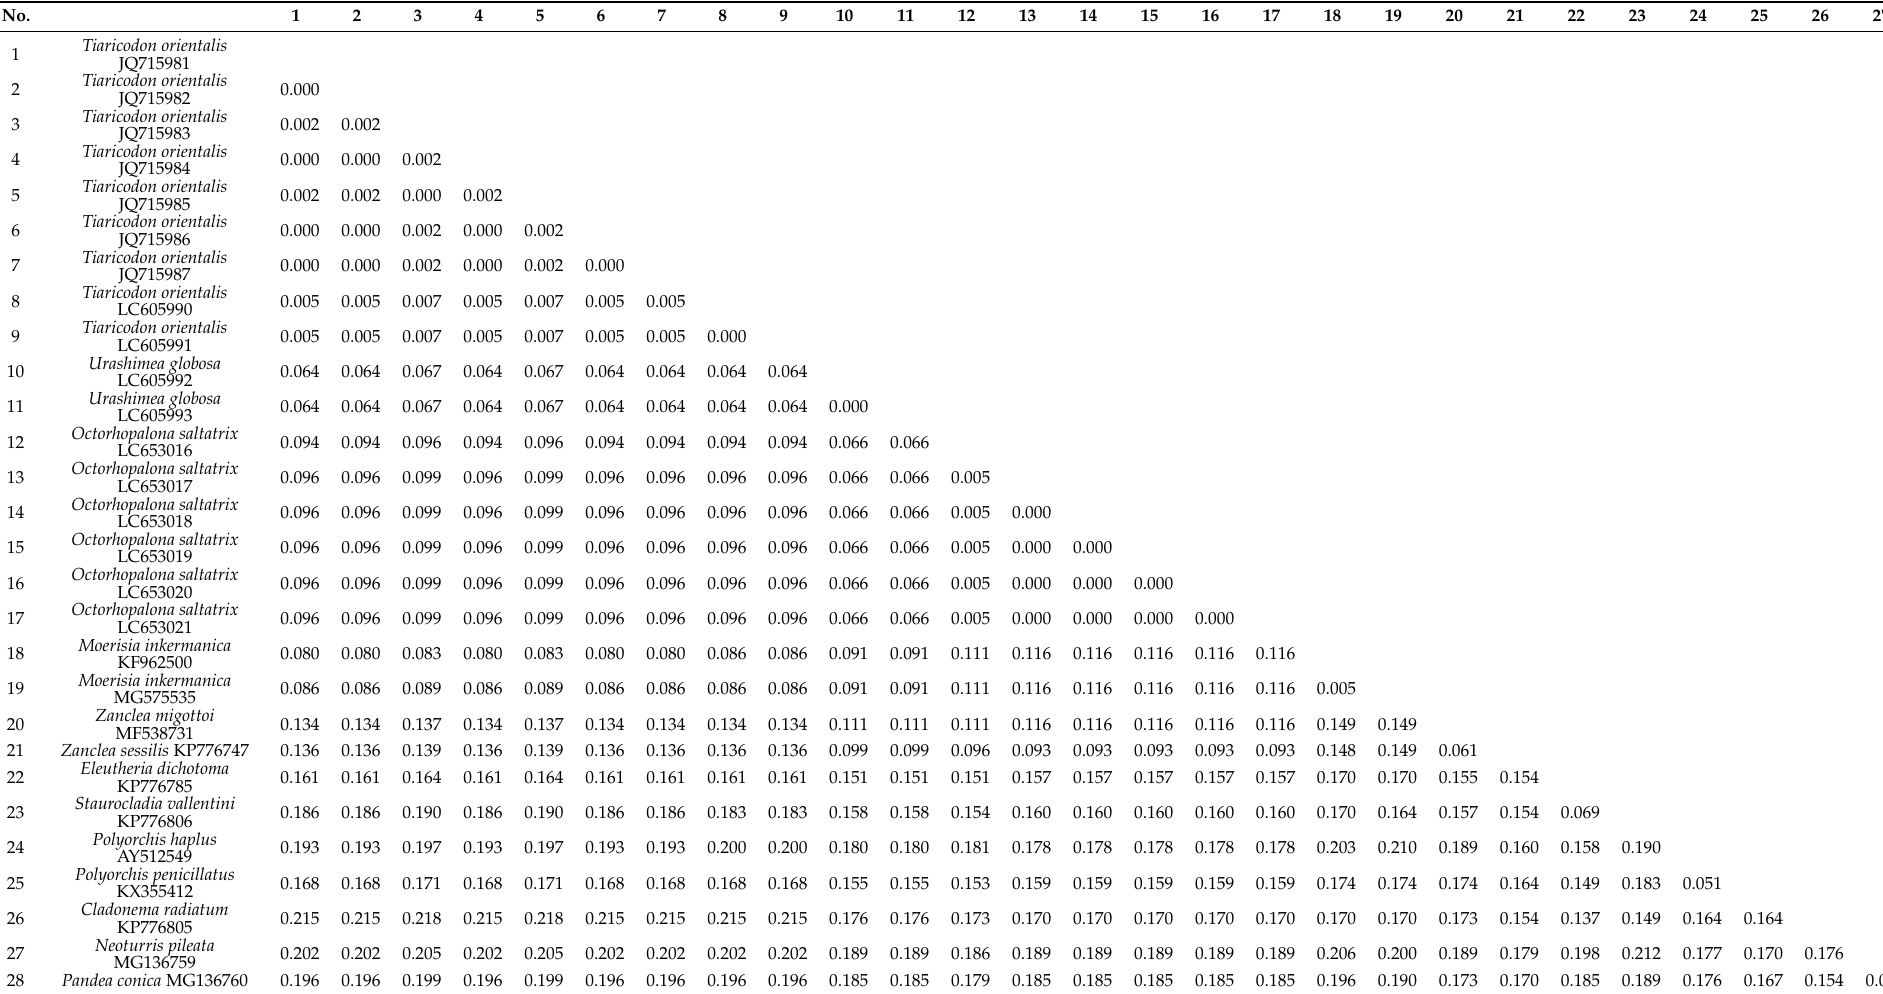
Table 2. Pairwise genetic distances (K2P) based on 440 positions of 16S sequences among Anthomedusae. The analysis involved 28